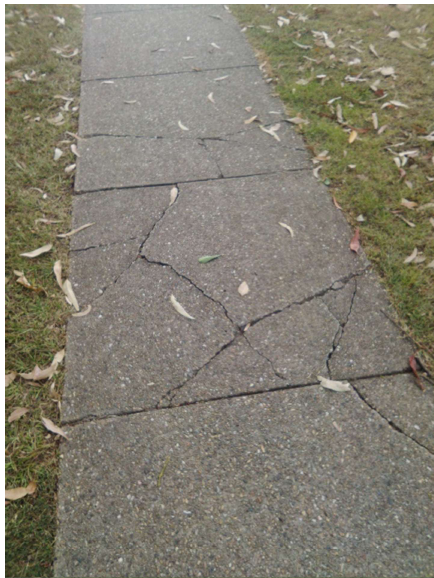
Figure 6. Damaged footpath.